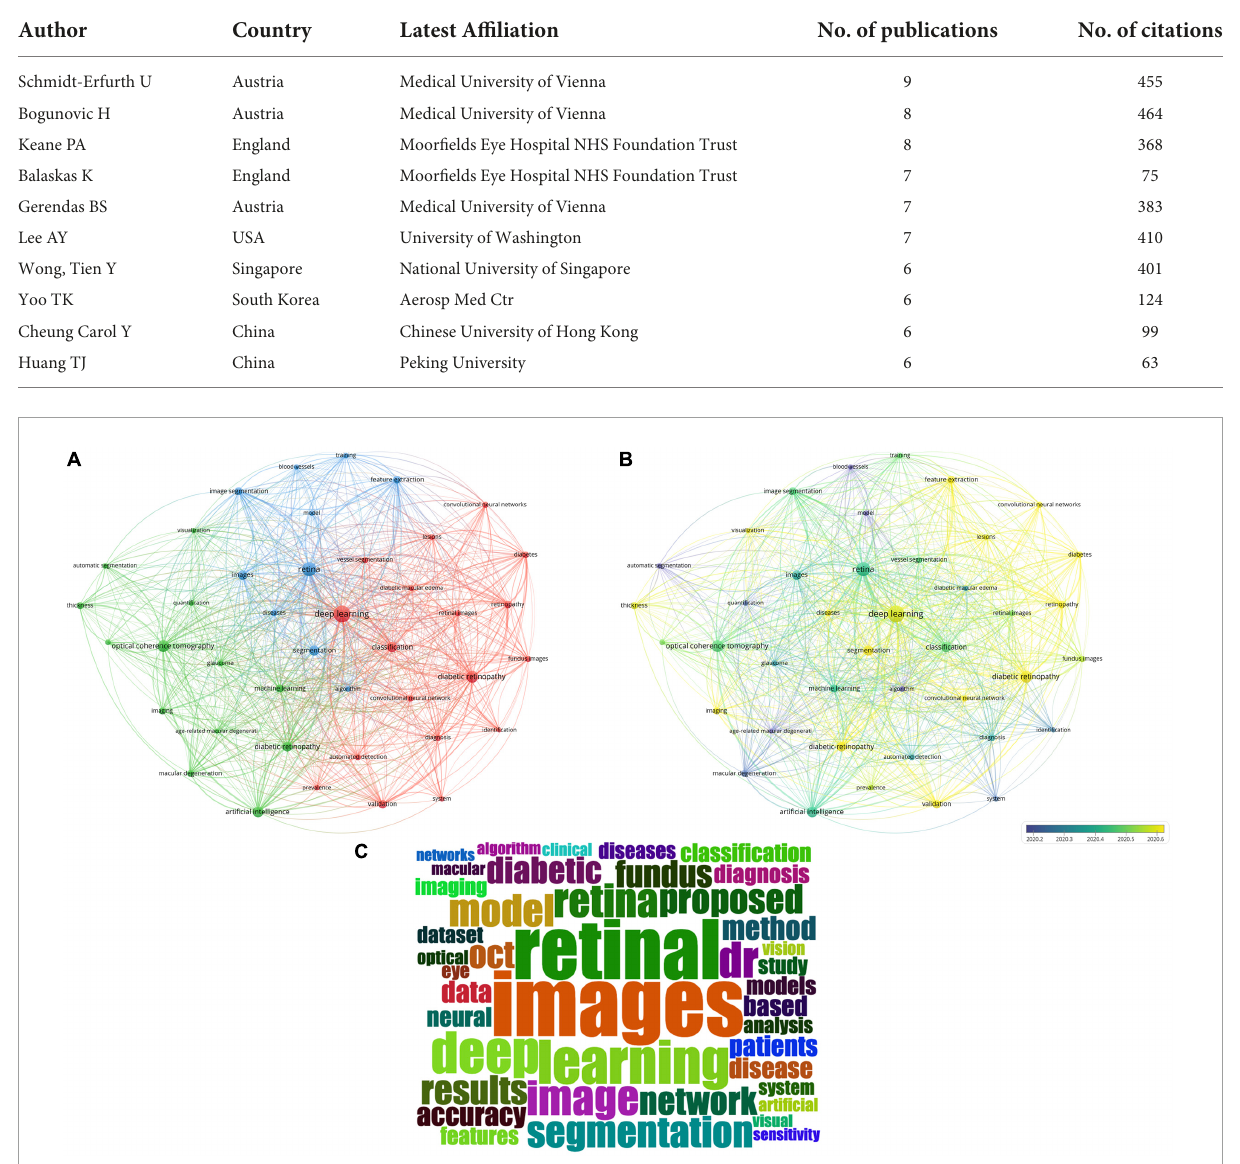
FIGURE4 Keywords analysis by VOSviewer and R. (A) Co-occurrence map of keywords in titles and abstracts. Keywords were classified into three clusters by co-occurrence frequency, including diabetic retinopathy-related cluster (in red), optical coherence tomography on multiple diseases-related cluster (in green), algorithm-related cluster (in blue). (B) Color-coded map of keywords by the average time of appearance. Blue keywords appeared earlier, while yellow keywords appeared more recently. (C) The wordcloud map the most frequent